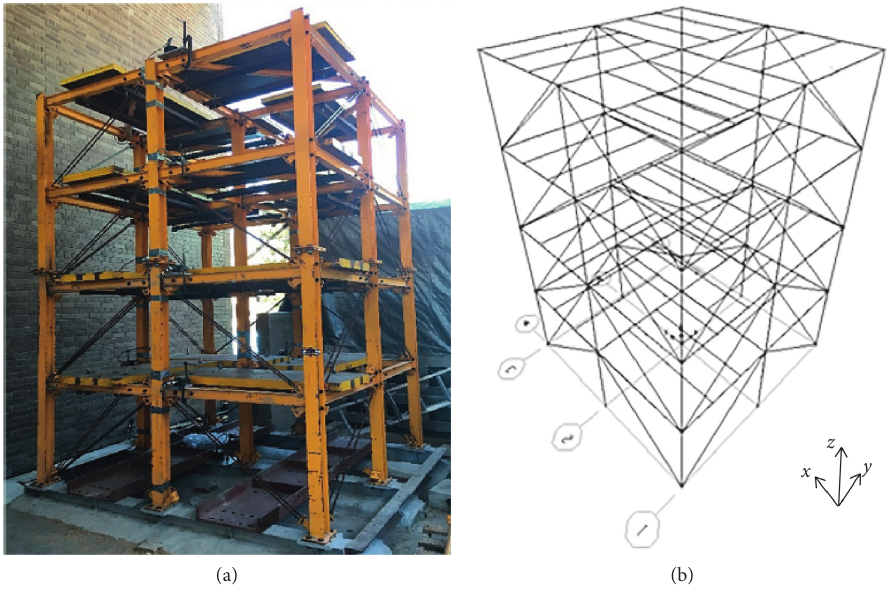
Figure 3: ASCE benchmark model: (a) steel-frame scale structure; (b) SAP2000 finite element